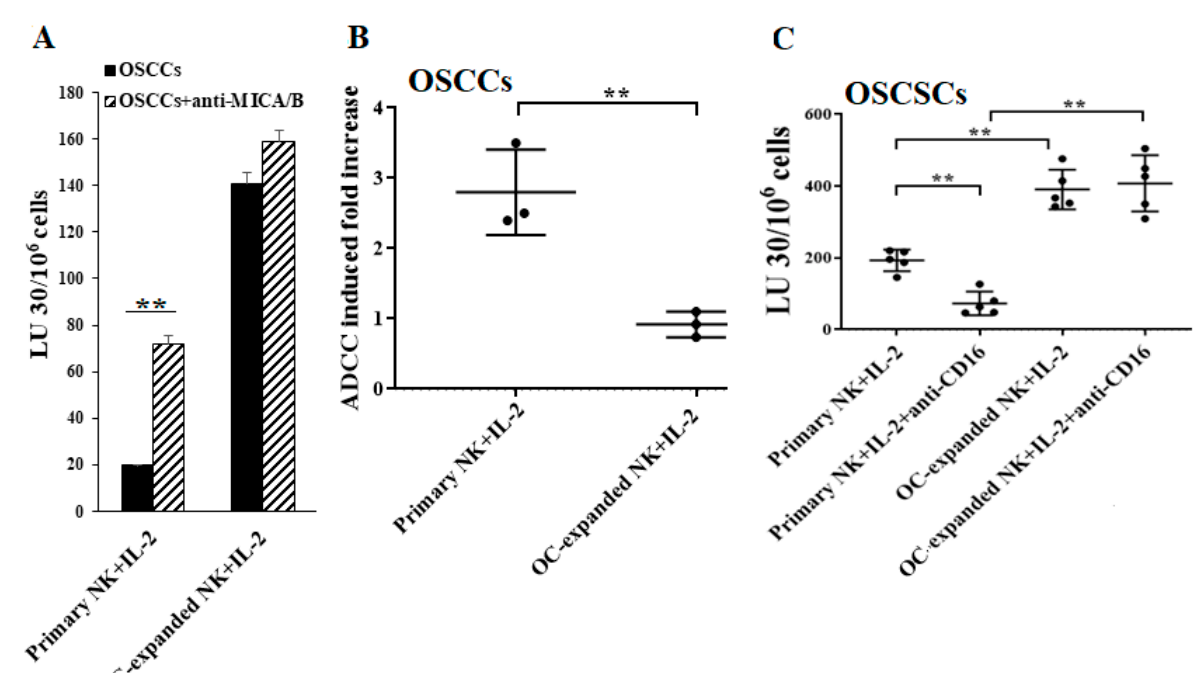
Figure 4. Higher levels of NK cell-mediated ADCC were seen in freshly isolated primary NK cells vs. in osteoclast (OC)-expanded NK cells. OCs were generated and OC-expanded NK cells were prepared as described in the Materials and Methods. Freshly purified primary and OC-expanded NK cells were both treated with IL-2 (1000 U/mL) for 18 h and were used as effector cells to measure NK cell-mediated ADCC against OSCCs as described in Materials and Methods ( A ). Fold increases in ADCC were calculated ( B ). Freshly purified primary and OC-expanded NK cells were treated with IL-2 (1000 U/mL) or a combination of IL-2 (1000 U/mL) and anti-CD16 mAbs (3 µg/mL) for 18 h before being used as effector cells to measure NK cell-mediated ADCC against OSCSCs as described in the Materials and Methods ( n = 5) ( C ). ** ( p value 0.001–0.01)